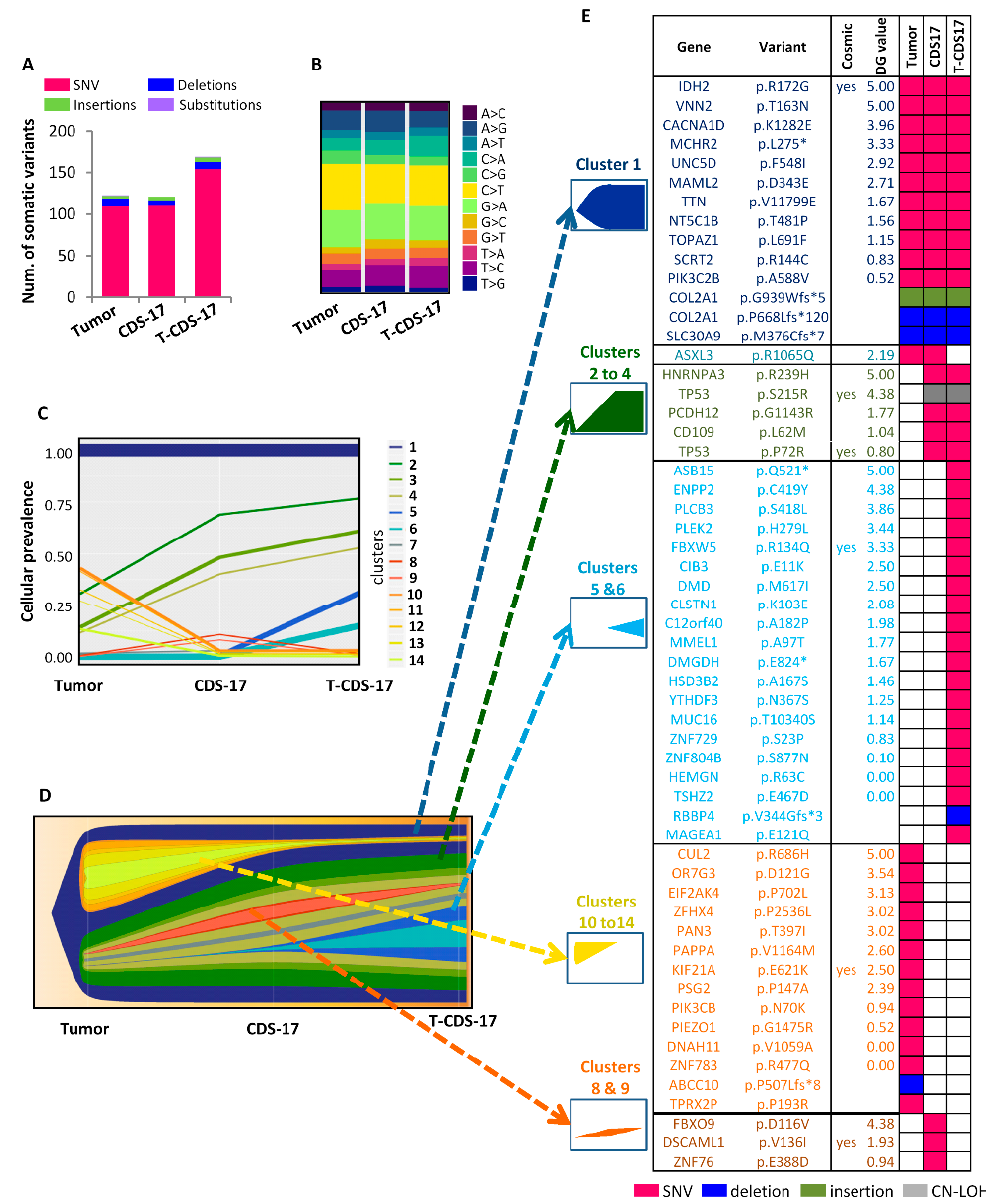
Figure 3. Clonal evolution of somatic mutations after in vitro and in vivo growth of chondrosarcoma cell lines. ( A , B ) Mutational burden data of a tumor patient sample and its derived cell lines CDS-17 and T-CDS17 obtained by whole exome sequencing (WES). The number and type of somatic mutations ( A ) and the profile of SNV transitions and transvertions ( B ) in each sample are shown. ( C , D ) Subclonal reconstruction was performed with PhyloWGS using WES data. The mean cellular prevalence estimates of mutation clusters in originating patient tumor sample and subsequent CDS17 and T-CDS17 cell lines are shown ( C ). Line widths represent the relative abundance of single nucleotide variants (SNVs) in each mutation cluster. Fish-plot representation of the di ff erent clusters in each sample is also shown ( D ). ( E ) List of non-synonymous somatic mutations detected in each cluster. Catalogue of Somatic Mutations in Cancer (COSMIC) status, DREAMgenics (DG) algorithm value, and mutation type are indicated. To select the most relevant somatic mutations included in each group of clusters presenting similar trends we compared tumor versus normal, CDS17 versus tumor and T-CDS17 versus CDS17 samples and filter the results to select variants with non-synonymous e ff ect on coded proteins which presented variant allele frequencies > 0.035 in tumor, CDS17 or T-CDS17 samples and maximum